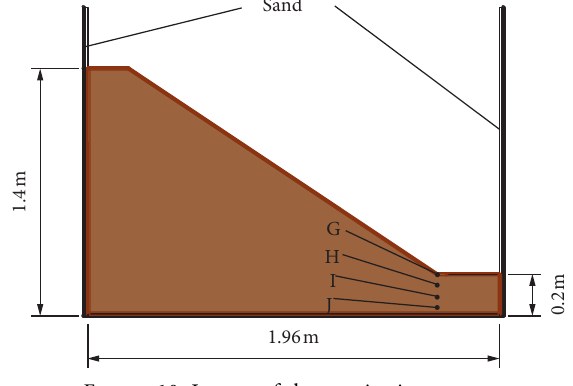
Figure 10: Layout of the monitoring sensor. Table 7: Parameters of the earthquake motions.